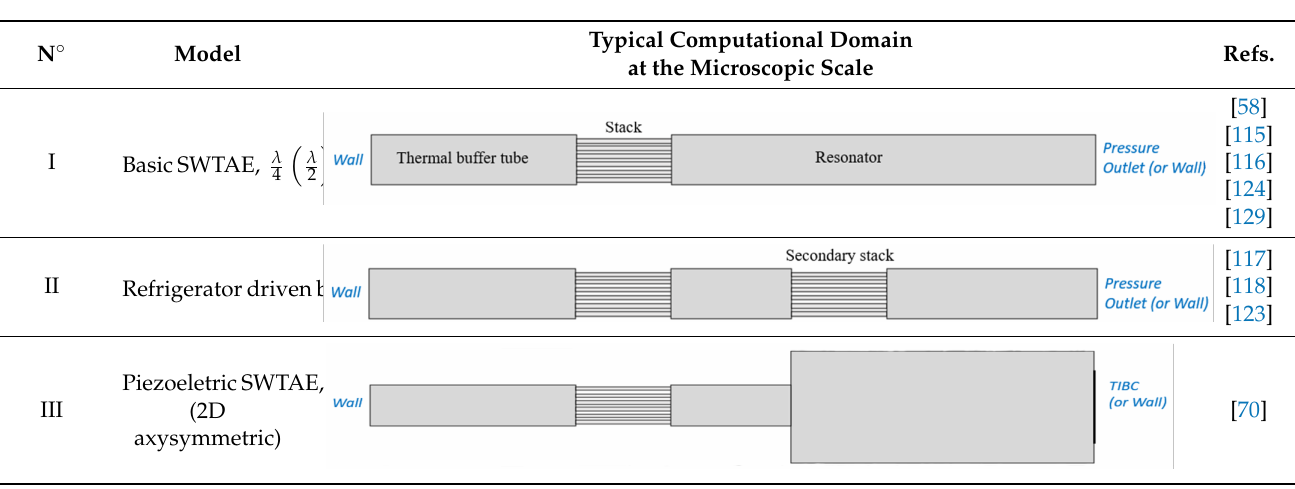
Table 3. Model and computational domain of full device simulations at the microscopic scale. In the second column, it is specified if the model is 3D or 2D